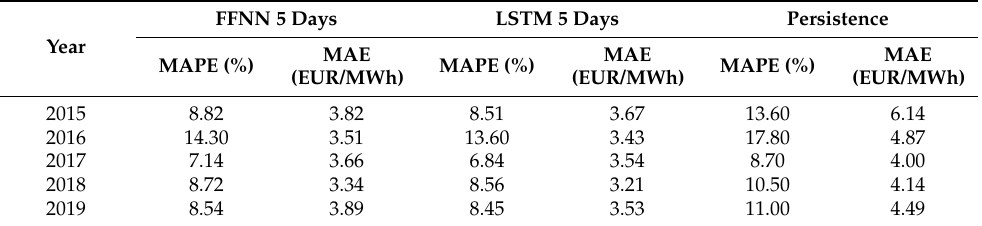
Table 8. Yearly forecasting error values of the FFNN 5 days, LSTM 5 days, and persistence